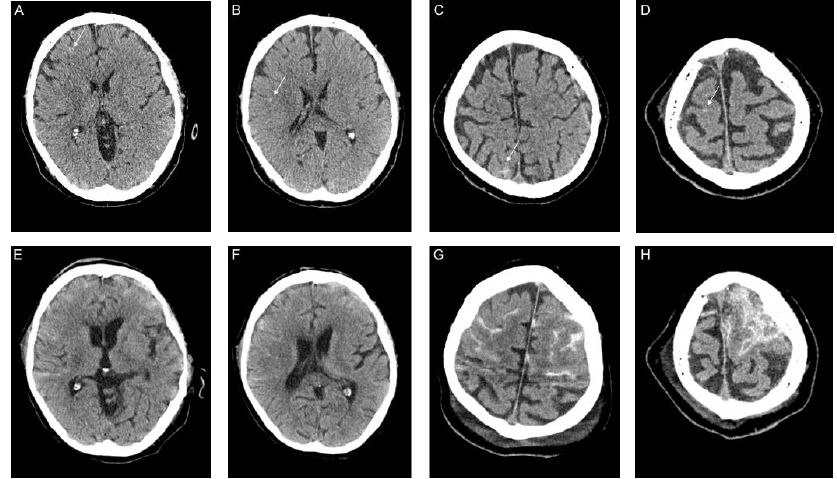
Figure 2. Representative computed tomography (CT) images of a patient with Coronavirus Disease 2019 with an acute subarachnoid hemorrhage (SAH). Legend: ( A – D ): Brain CT image two days after hospitalization. ( E – H ) Brain CT image seven days after hospitalization. White arrow indicates acute SAH.